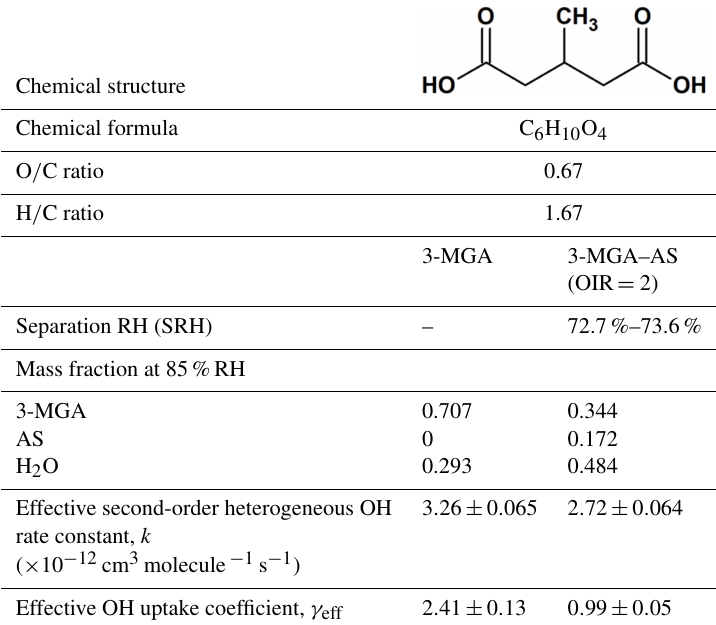
Table 1. Chemical structure, properties, effective heterogeneous OH rate constant, effective OH uptake coefficient of 3-methylglutaric acid (3-MGA) and 3-MGA mixed with ammonium sulfate (AS) in an organic-to-inorganic dry mass ratio (OIR) =